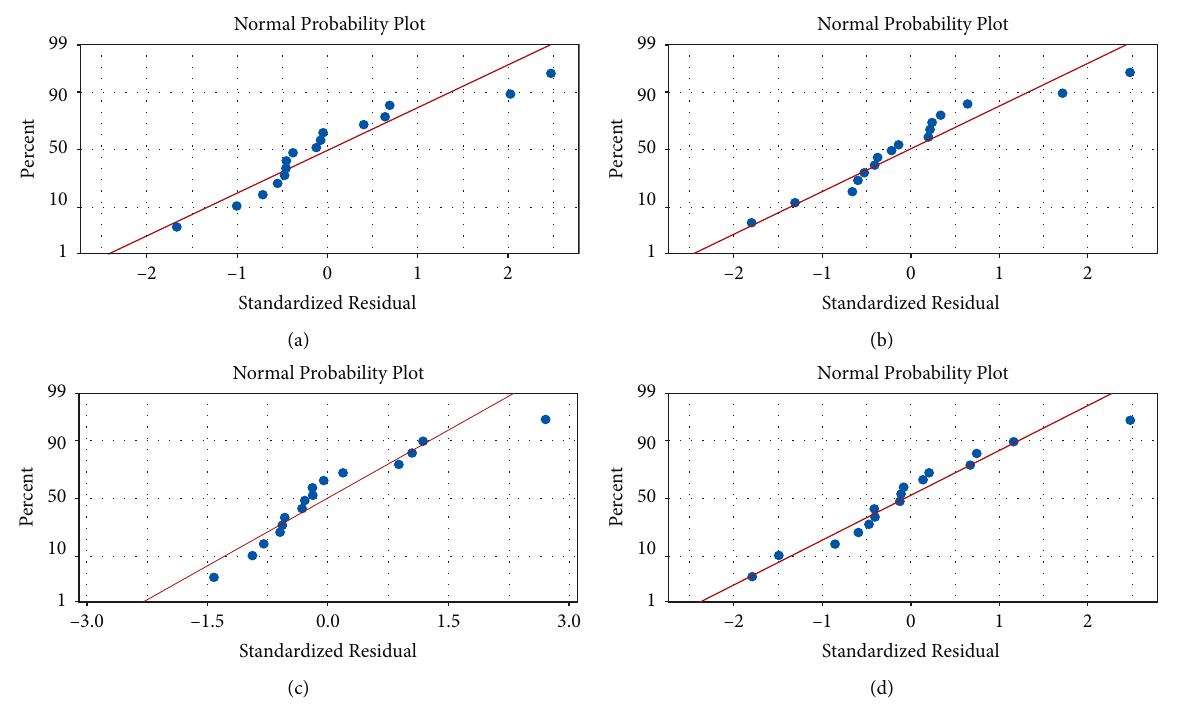
Figure 4: Normality graph: (a) fcs